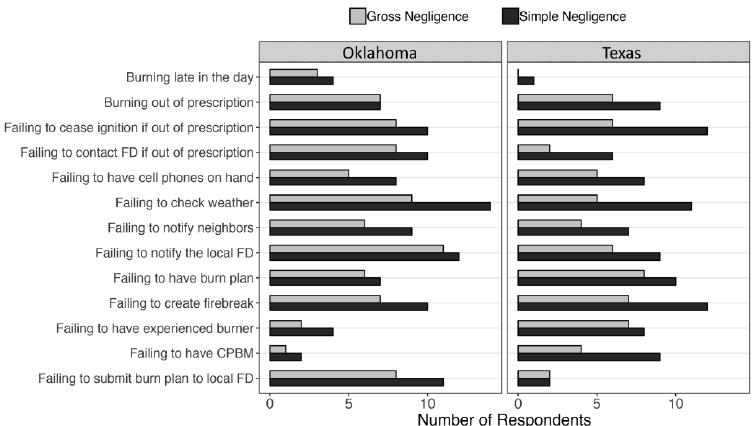
Figure 2. District judges’ selection of factors that constitute evidence from which a jury